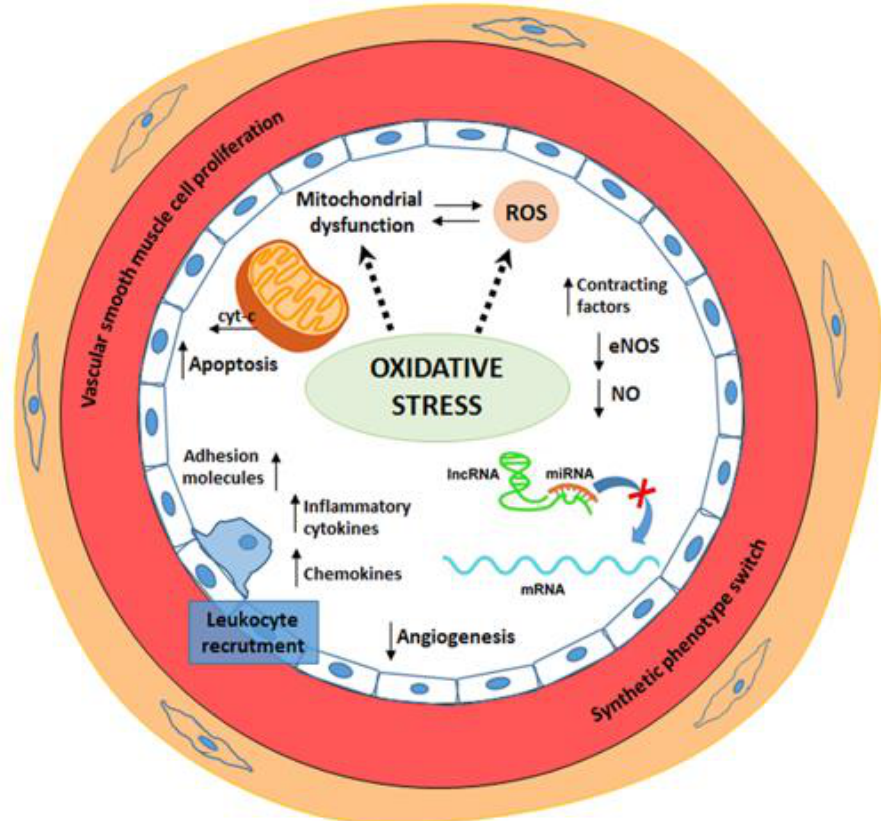
Figure 1. Schematic representation of the main pathogenetic mechanisms involved in endothelial dysfunction. Endothelial dysfunction is defined as an impaired vasodilation and a proinflammatory and prothrombotic status. Endothelial dysfunction-induced phenotypic changes include eNOS inactivation and diminished availability of NO, up-regulated expression of adhesion molecules and increased chemokine secretion, leukocyte adherence, cell permeability, low-density lipoprotein oxidation, platelet activation, and vascular smooth muscle cell proliferation and migration. Inflammation-induced oxidative stress results in an increased accumulation of reactive oxygen species (ROS), mainly derived from mitochondria. Excessive ROS production causes oxidation of macromolecules inducing cell apoptosis mediated by cytochrome-c release (cyt-c). Oxidative stress increases vascular permeability, promotes leukocyte adhesion and induces alterations in endothelial signal transduction and redox-regulated transcription factors. Recently, alterations of gene regulatory mechanisms and deregulation of non-coding RNAs (miRNAs, lncRNA) have been reported to contribute to endothelial dysfunction.